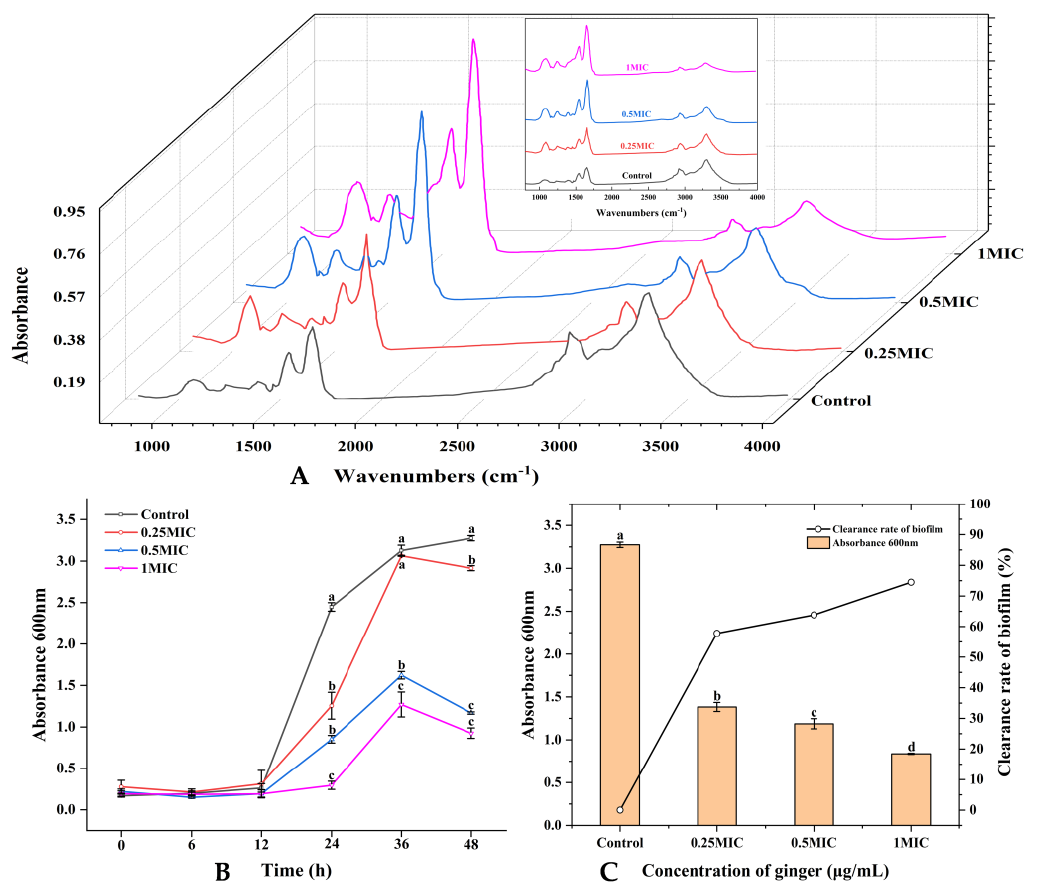
Figure 2. Analysis of ( A ) FTIR, ( B ) the growth curve of biofilm ( C ) removal activity. ( A ) expresses the changes produced in FTIR by S. putrefaciens with the change of GEO concentration. ( A ) indicates the growth curves of biofilms of S. putrefaciens at different GEO concentrations. ( C ) indicates the ability of different concentrations of GEO to eliminate the biofilms of S. putrefaciens . Different colors in ( A , B ) indicate different concentrations (Black—Control, Red—0.25 MIC, Blue—0.5 MIC, Violet—1 MIC). Different lowercase letters indicate significant difference ( p < 0.05).